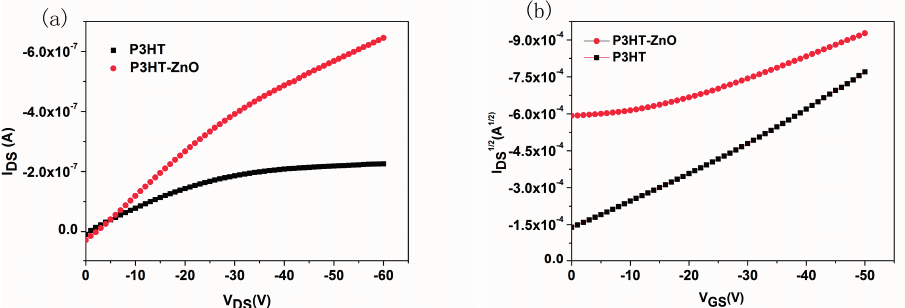
Figure 6. The typical ( a ) output ( V GS = − 30 V) and ( b ) transfer ( V DS = − 50 V) characteristics curves of P3HT and P3HT-ZnO films based OTFT